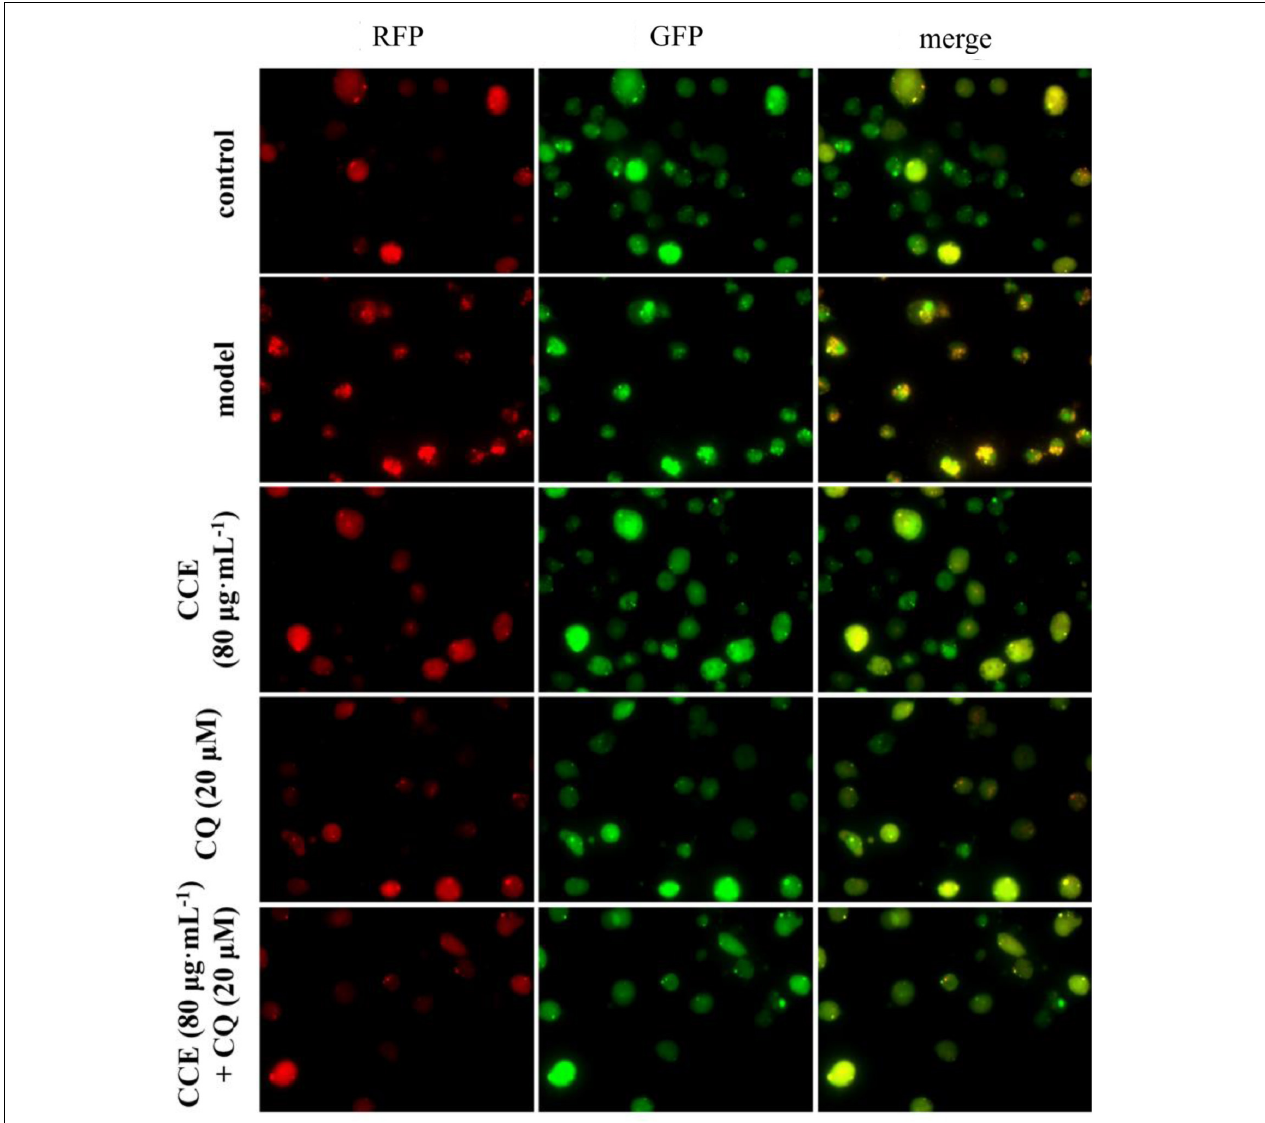
FIGURE 6 | Effects of CCE on autophagy flux of NHBE cells by laser confocal microscopy. mRFP-GFP-LC3 double fluorescence system was used for this determination. Cells were treated with an mRFP-GFP-LC3 lentivirus for 24 h and then treated with rapamycin (200 nmol · L − 1 ) for 3 h. The red fluorescent represents the formation of autolysosom while green fluorescent represents the formation of